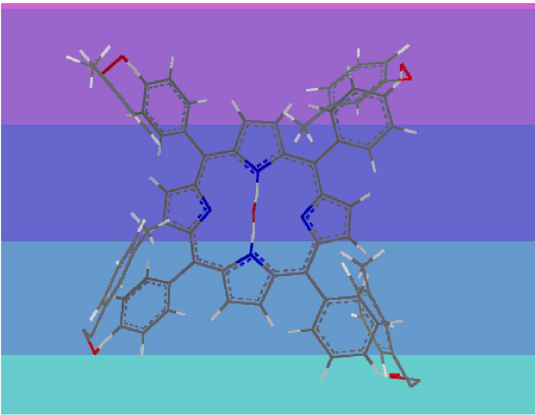
Figure 1. Zn-Porphyrin